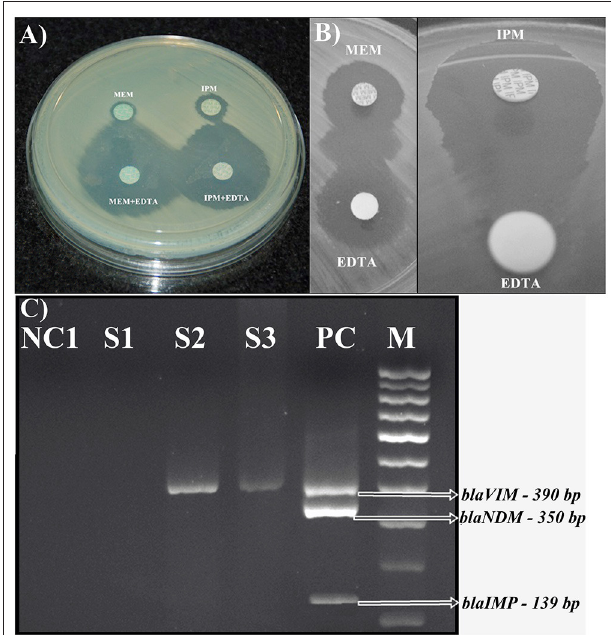
FIGURE 2 | Phenotypic detection of M β L producing isolates (A) CDT , Combined disc test showing a positive result, the enhanced zone of inhibition around the imipenem + EDTA (10 µ g + 750 µ g) ( Right below ) and meropenem + EDTA (10 µ g + 750 µ g) ( Left below ) disc by ≥ 7mm as compared to the imipenem (10 µ g) ( Right ) and meropenem (10 µ g) ( Left ) disc alone by a bla VIM gene of P. aeruginosa . (B) DDST , Double disc synergy test portraying a synergistic inhibition zone between a meropenem disc (10 µ g) ( Left side—Top ) and Imipenem disc (10 µ g) ( Right side—Top ) and an EDTA disc (750 µ g) ( Down both Right and left side ) as presented by a bla VIM gene of P. aeruginosa . (C) Agarose gel electrophoresis (1.5%) used for the separation of multiplex PCR products. Results of multiplex PCR detecting bla VIM genes; Lane NC1 and NC2: Blank controls. Lane S1 —Negative amplification of M β Ls genes. Lane S2 and S3: amplified products of bla VIM genes among gram-negative bacterial isolates from preoperative conjunctival flora and ocular infections. Lane PC : amplified products of positive control strains carrying bla VIM gene (390 bp), bla IMP gene (162 bp), and bla NDM gene (350 bp). Lane MW : Molecular weight marker 100-bp DNA